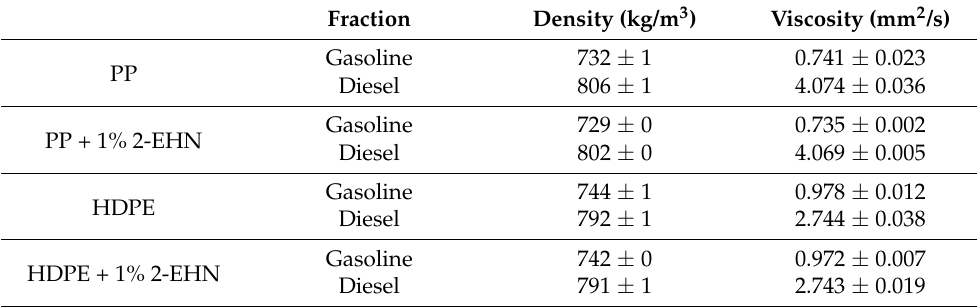
Table 2. Density and viscosity results for pyrolysis oil distillates. Fraction Density (kg/m 3